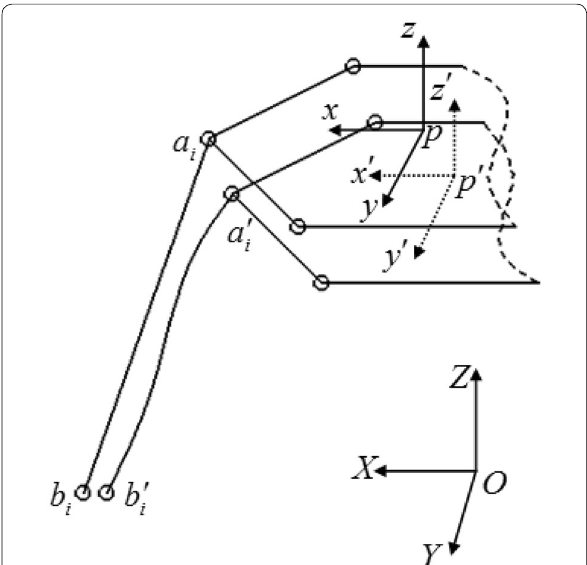
Figure 6 Coordination and constraint relationship between moving platform and branched